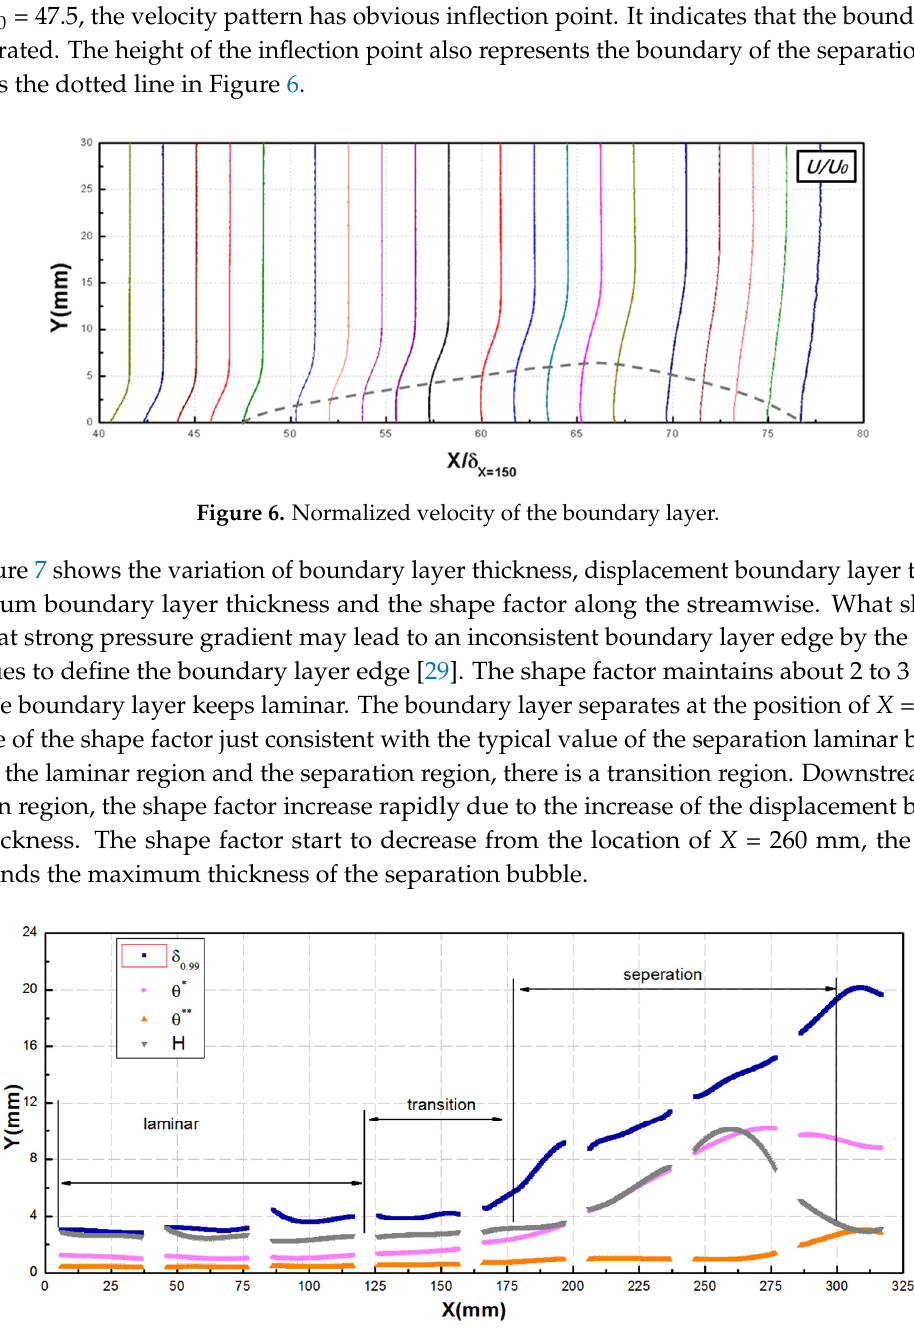
Figure 7. Streamwise variation of the boundary layer parameters.